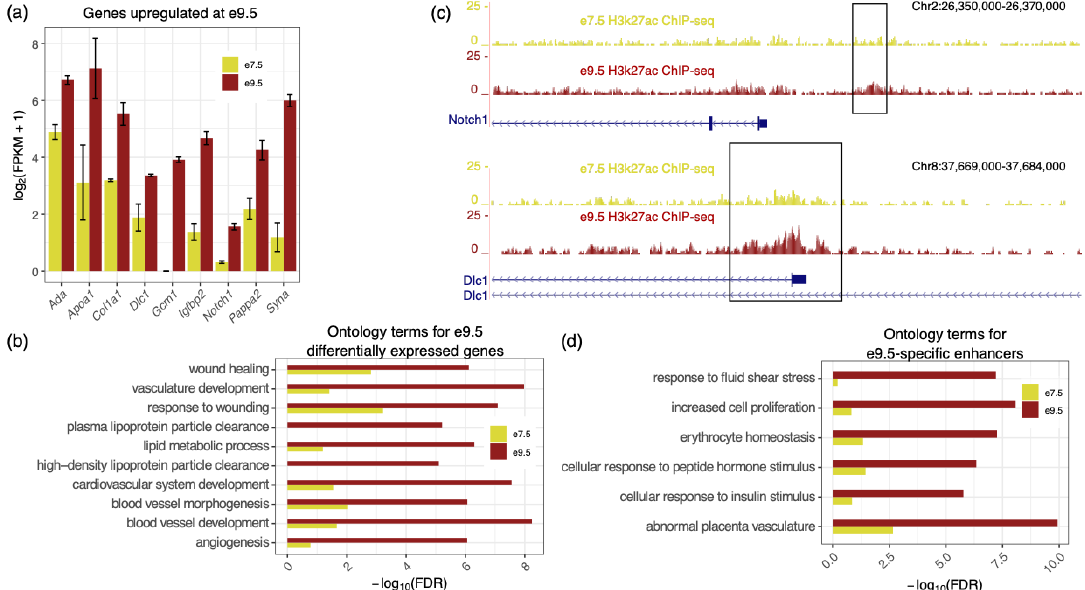
Figure 1. Genes and enhancers enriched in the placenta at e9.5 are associated with vasculature development. ( a ) Examples of genes significantly upregulated at e9.5 (FPKM ≥ 10, fold ≥ 2, and FDR ≤ 0.05) that are also associated with placental functions. ( b ) Top 10 GO biological process terms, according to GREAT, using the hypergeometric fold ( ≥ 2), FDR ( ≤ 0.05), and gene association ( ≥ 5 associated genes) cuto ff s. Genes significantly upregulated at e9.5 are related to lipid metabolism, and vasculature development. ( c ) Examples of e9.5-specific enhancers and their corresponding H3k27ac activity at e9.5 and e7.5, shown using the UCSC genome browser. Boxes correspond to regions identified as e9.5-specific. ( d ) E9.5-specific enhancers are associated with genes involved in proliferation, response to hormones, and placenta vasculature development.